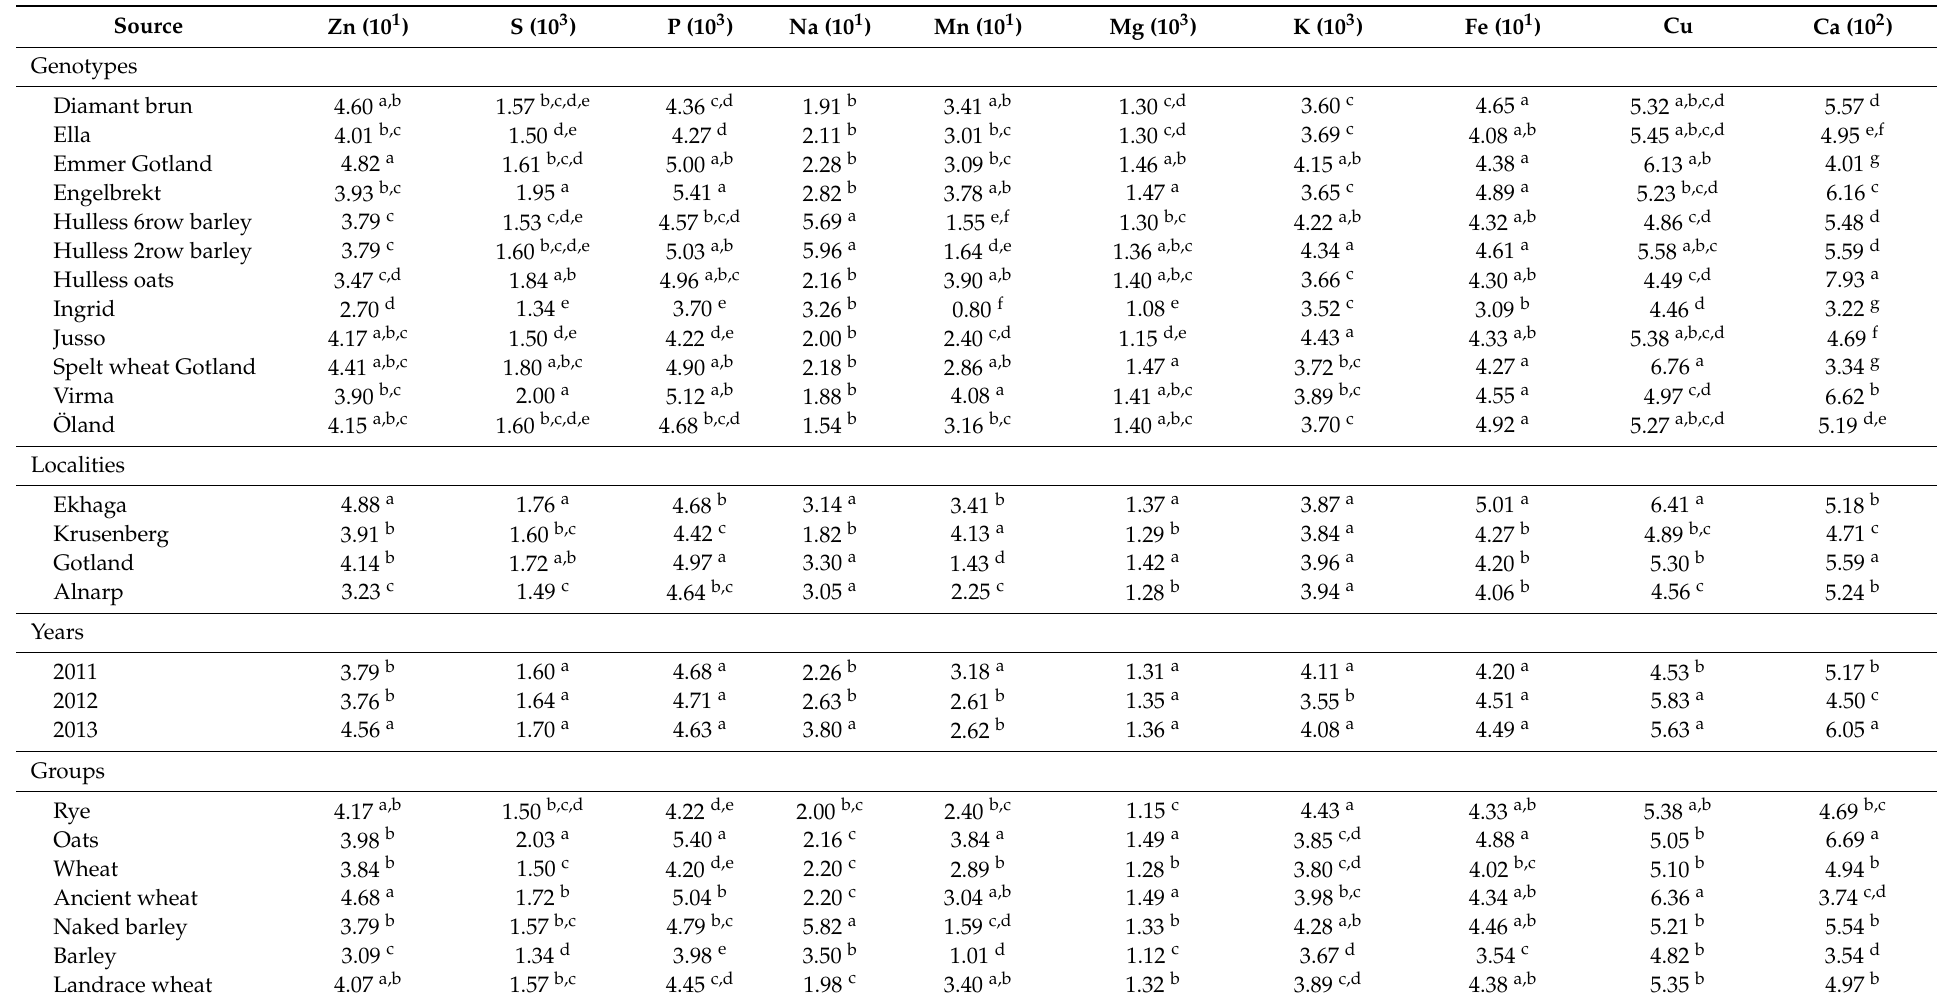
Table 5. Mean values of content of minerals (mg kg − 1 ) in twelve genotypes over four localities and three cultivation